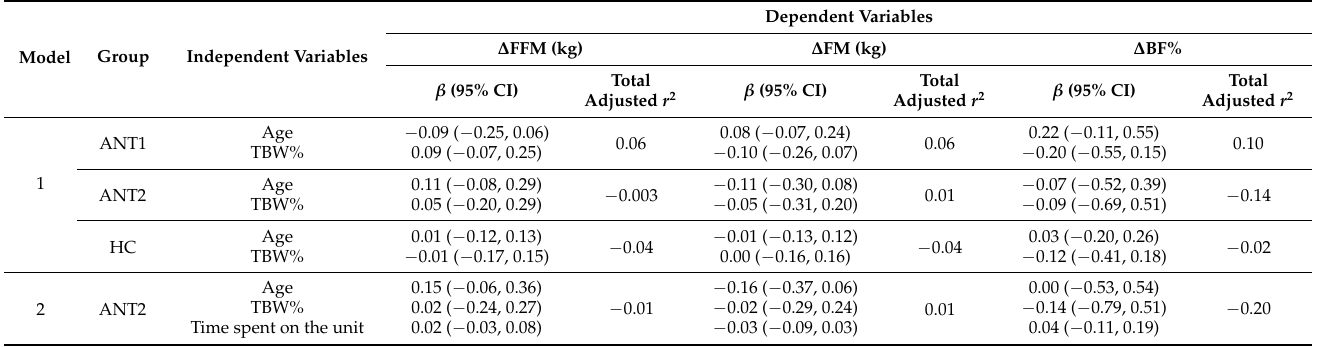
Table 2. Association of age, total body water percentage, and time spent on the inpatient specialist unit with the difference (delta, ∆ ) in DXA and BIA derived body composition measures.